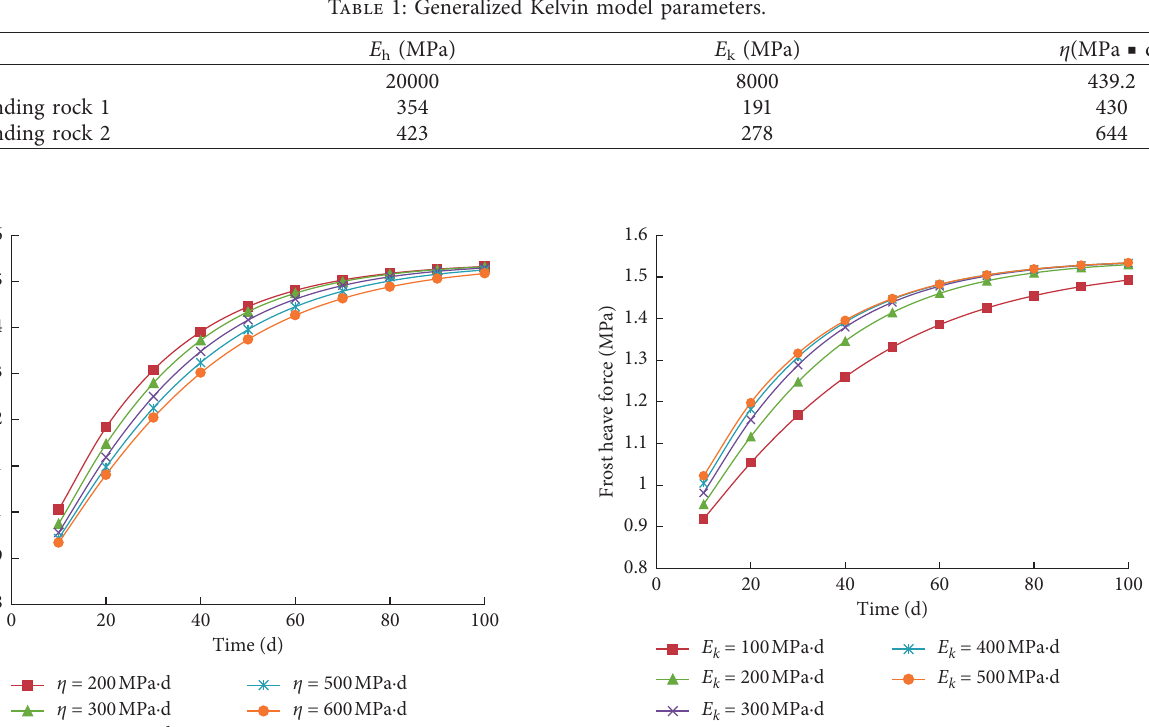
Figure 6: Frost heaving force-time curve under different sur- rounding rock elastic modulus E h